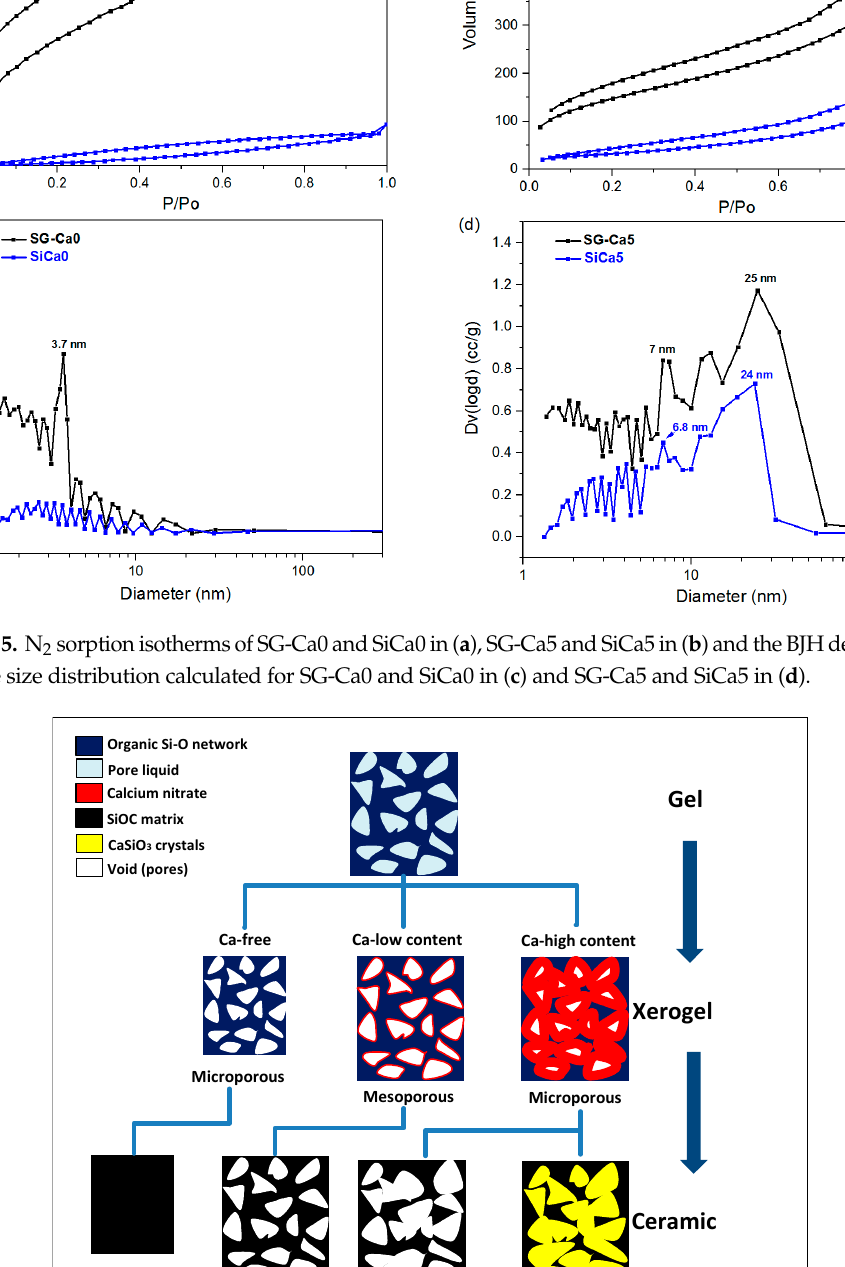
Figure 6. Schematic illustration of the porosity evolution from gels to xerogels, and then to silicon oxycarbide materials and the porosity dependency on the designed Ca/Si molar ratio.